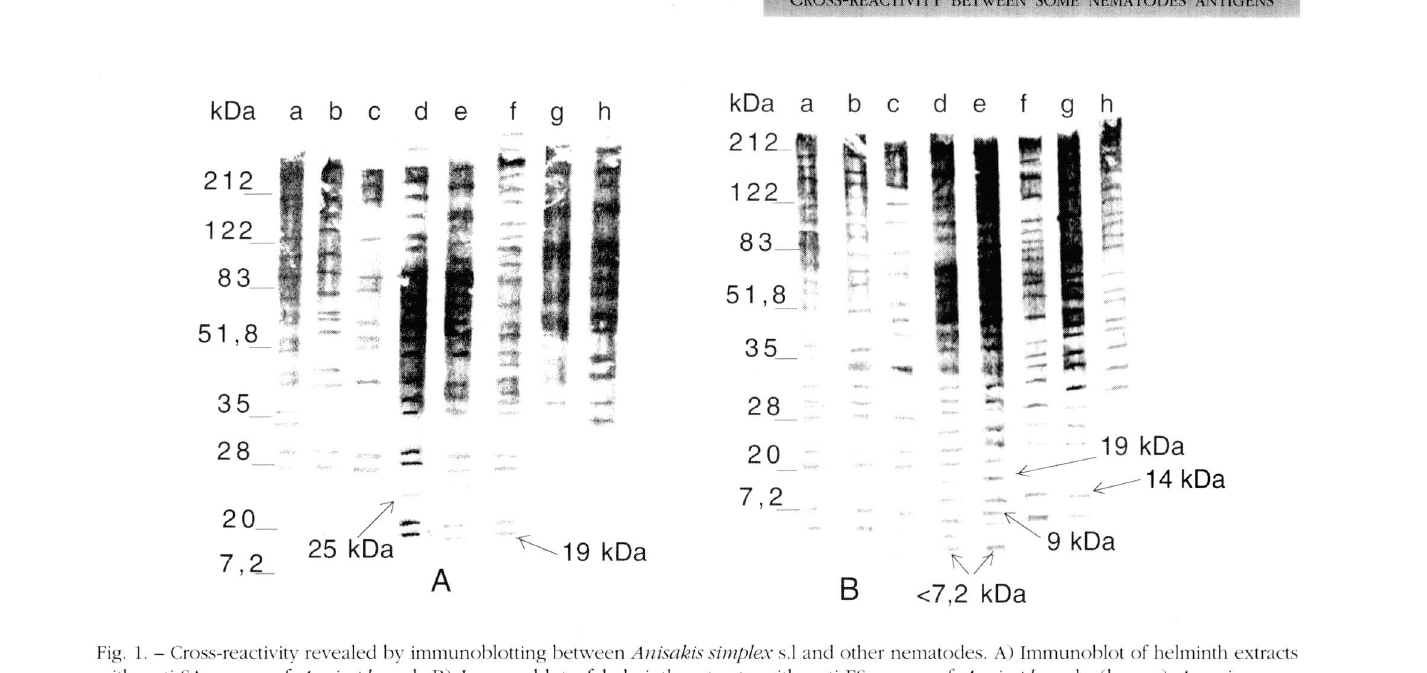
in the different species of nematodes studied. Also it revealed a band of low Mw (14 kDa) in A. simplex s.l., A. physeteris and Hysterothylacium antigens, two bands of < 7.2 and 19 kDa in both antigens of A. simplex